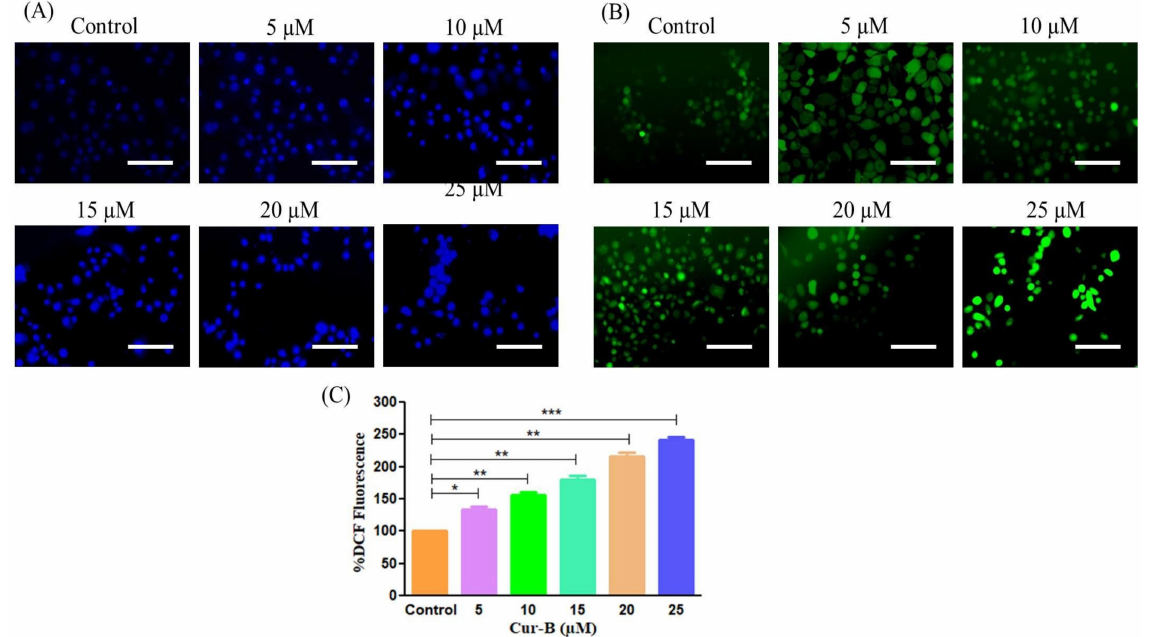
Figure 2. The efficacy of Cur-B in instigating ( A ) nuclear condensation and ( B ) intracellular ROS production, and ( C ) quantification of ROS production in PC-3 cells. Scale bar = 100 µ m. * p < 0.05, ** p < 0.01, *** p <